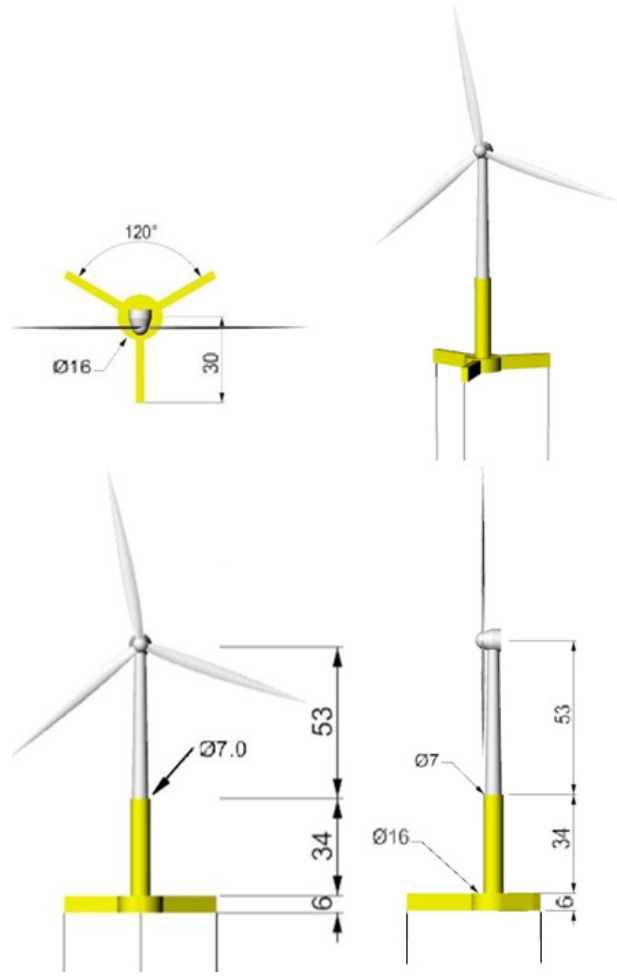
Figure 3. The schematic diagrams of the NREL 5MW wind turbine mounted on the UMaine TLP with the taut-leg mooring system in different views. (Unit: m.)